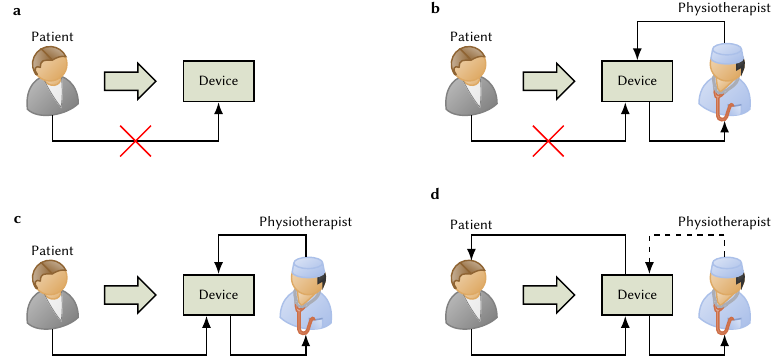
Figure 5. Types of rehabilitation systems: ( a , b ) no feedback—open loop, ( c ) classical feedback—closed loop, ( d ) full biofeedback—closed loop.